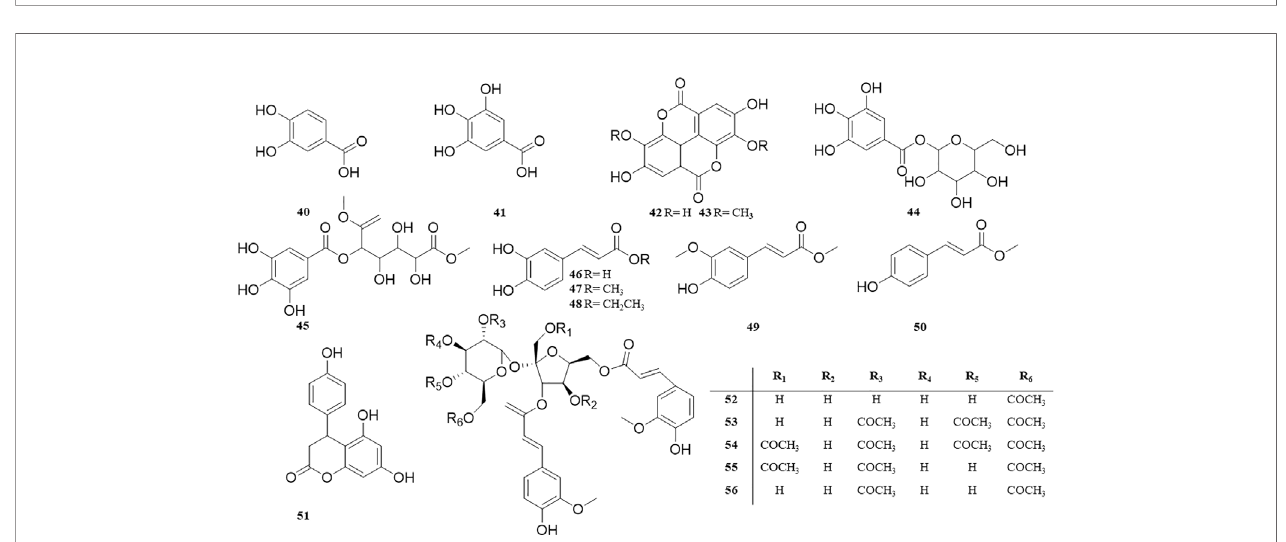
FIGURE 5 | Structure of phenolic acids from P.